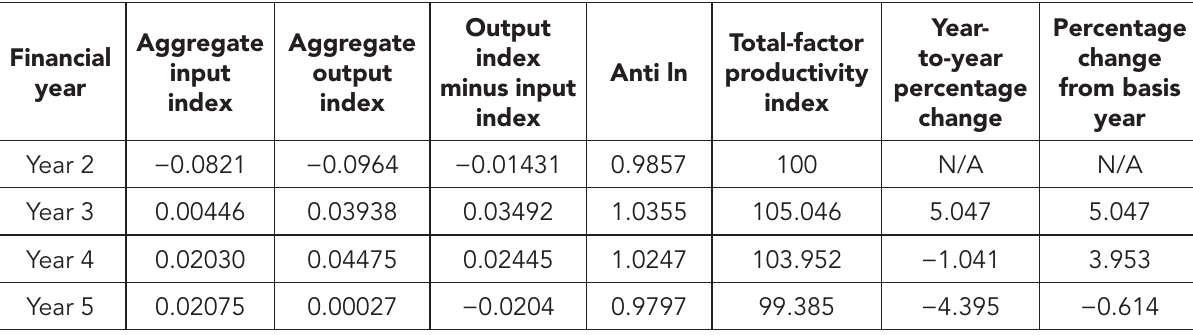
Table I: Yearly total-factor productivity changes and growth